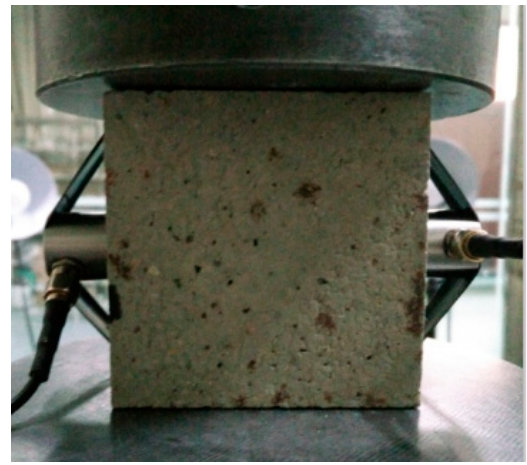
Figure 3. Arrangement of acoustic sensors.